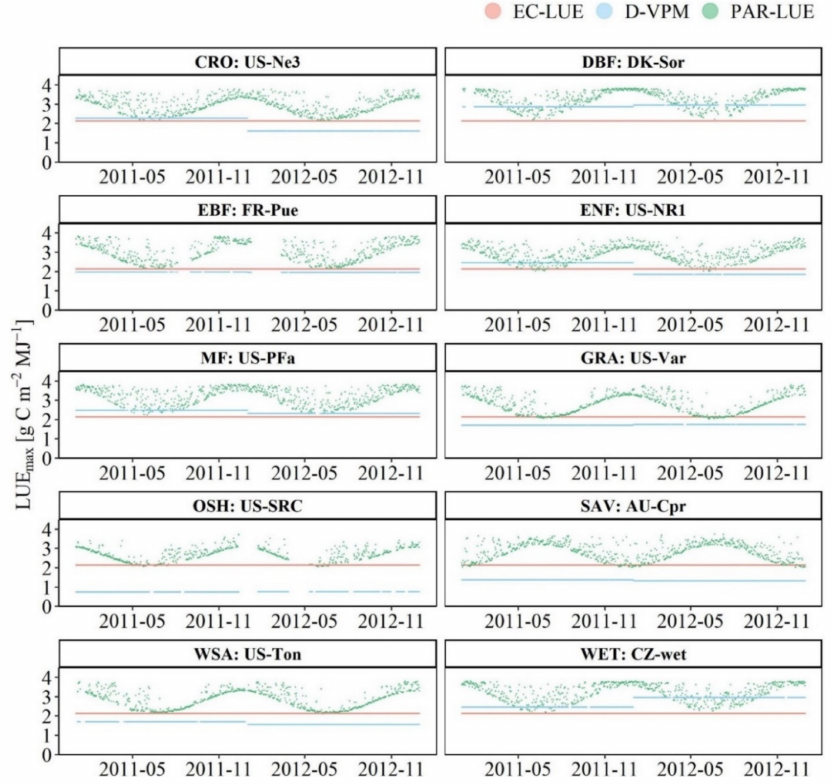
Figure 4. Seasonal dynamics comparison of three E max at typical sites. Ten sites from different vegetation types were selected and shown in two adjacent years (2011–2012) to exhibit the differences in seasonal variation among the three E max